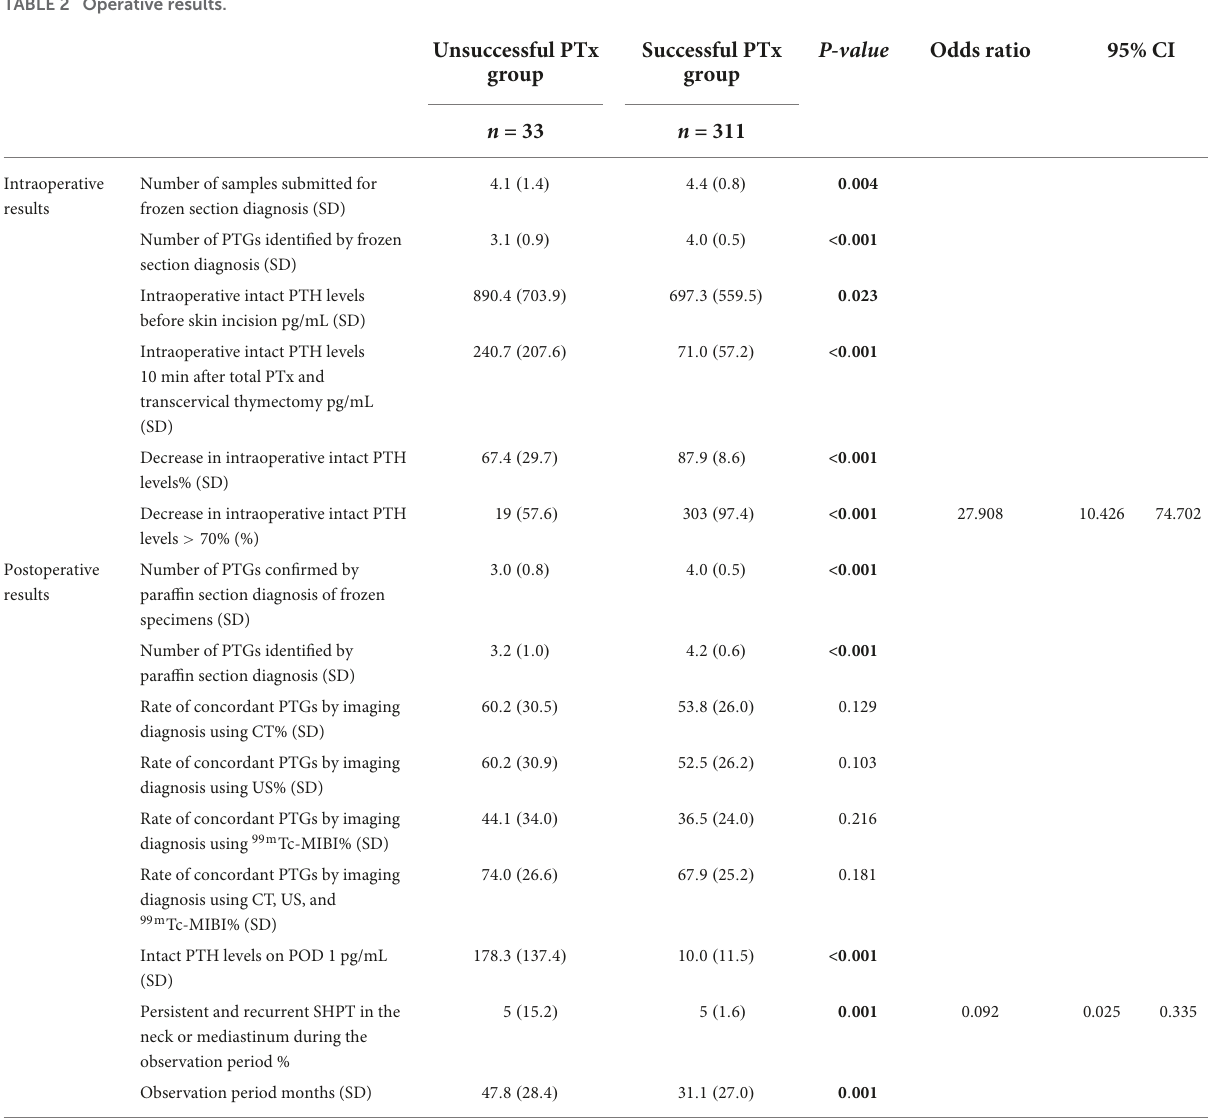
TABLE 2 Operative